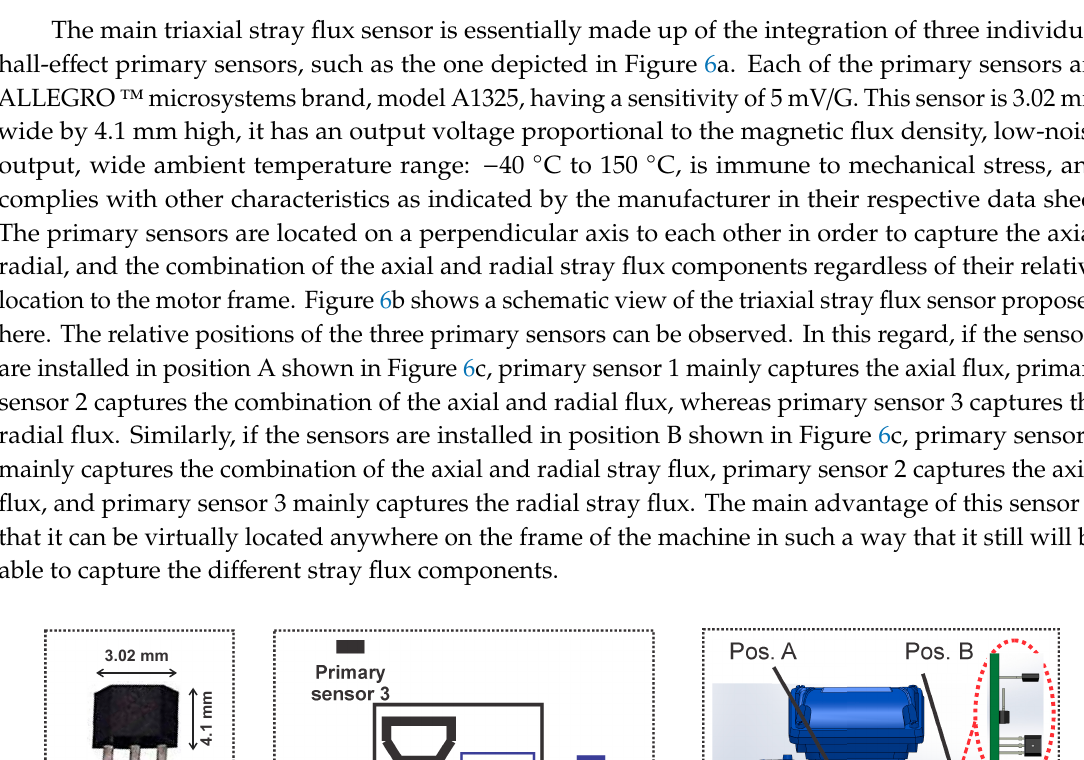
Figure 5. Smart–sensor dimensions.